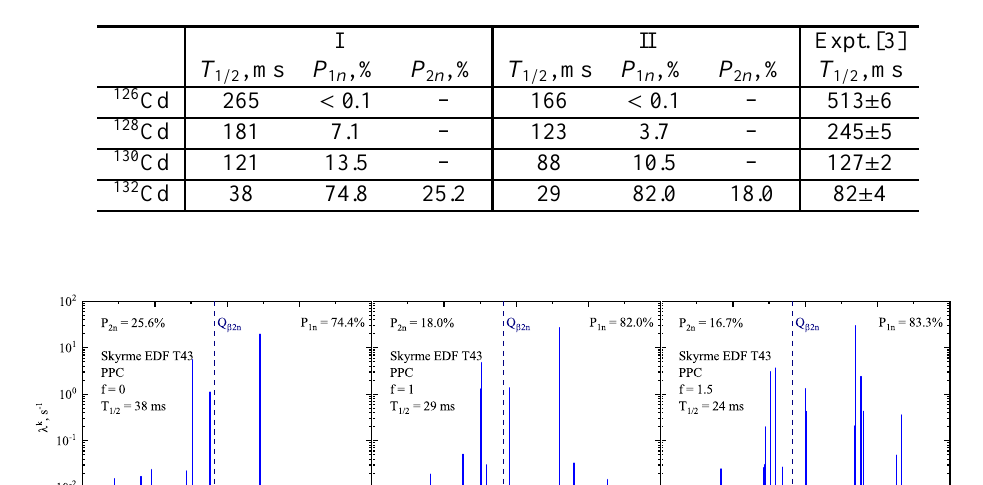
Table 1. The e ff ect of pairing interaction on the half-lives ( T 1 / 2 ) and neutron-emission probabilities ( P 1 n , P 2 n ) of Cd isotopes. Calculations are performed within the model, that includes the PPC e ff ects, with (I) and without (II) taking into account residual interaction in the pp channel. For 130 Cd the experimental P n , tot value of